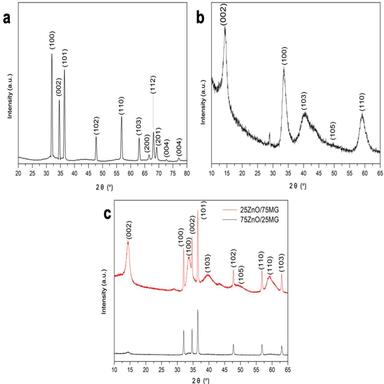
XRD images of synthesized materials. (a) ZnO nanorods, (b) MG composite, (c) ZnO/MG hybrids.